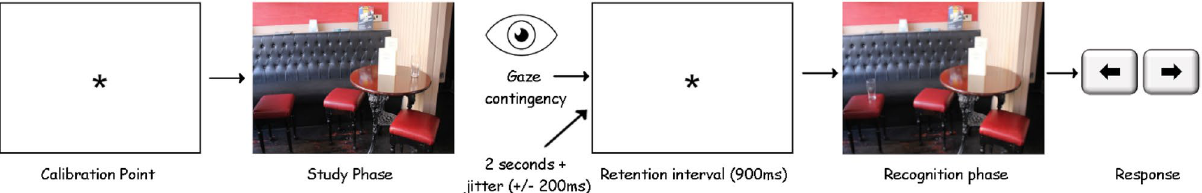
Figure 3. Schematic representation of a trial. Each trial starts with a drift correction. Then the study scene appears. When the gaze of the participant enters the critical object and dwells in it for 150 ms, the image stays on screen for an additional 2 s (with a jitter of 200 ms), after which a retention interval screen (a fixation cross presented for 900 ms) appears. Then, the scene appears again (recognition), and the participant has to state whether there was a change or not in the scene by pressing the keyboard. Our analysis of the eye-movements focused on responses collected during the recognition